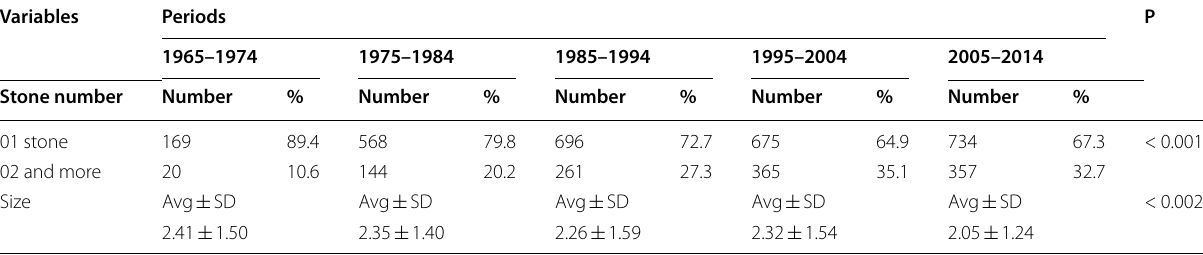
Avg: average, SD: standard